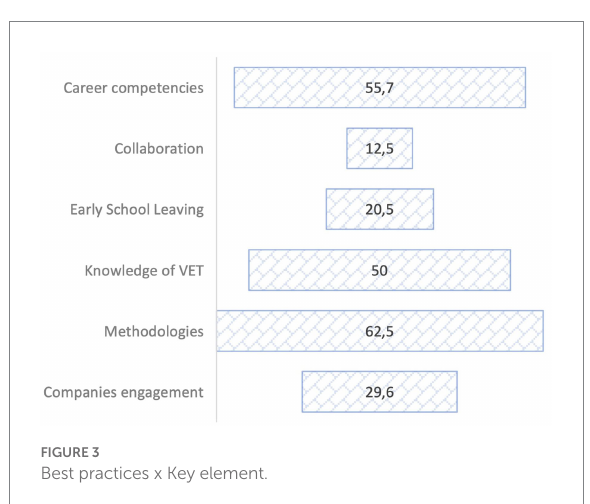
FIGURE 3 Best practices x Key